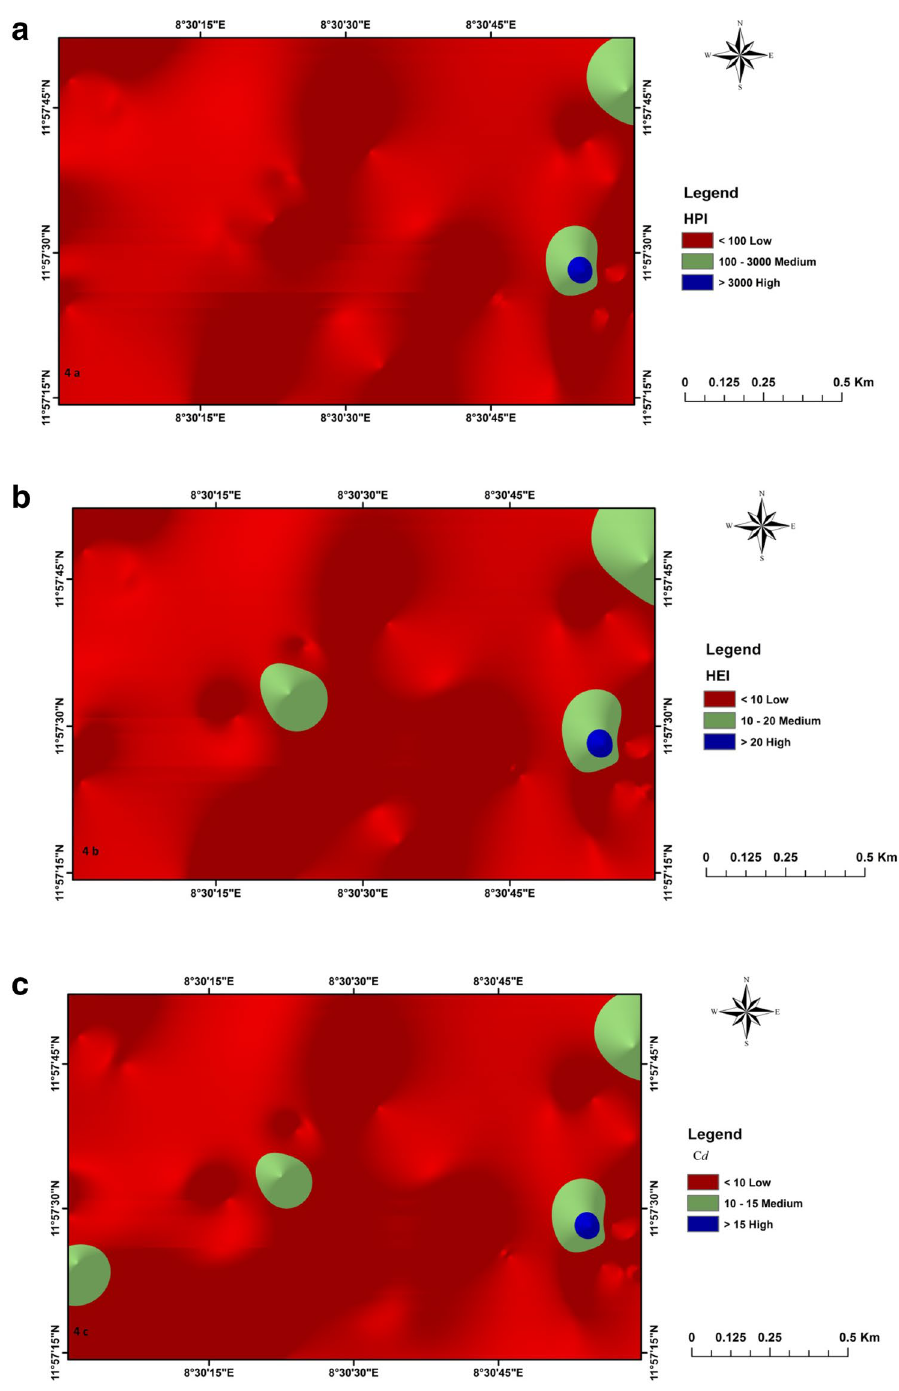
Fig. 4 a – e Spatial variation maps of pollution indices indi- cating level of groundwater pollution in the study